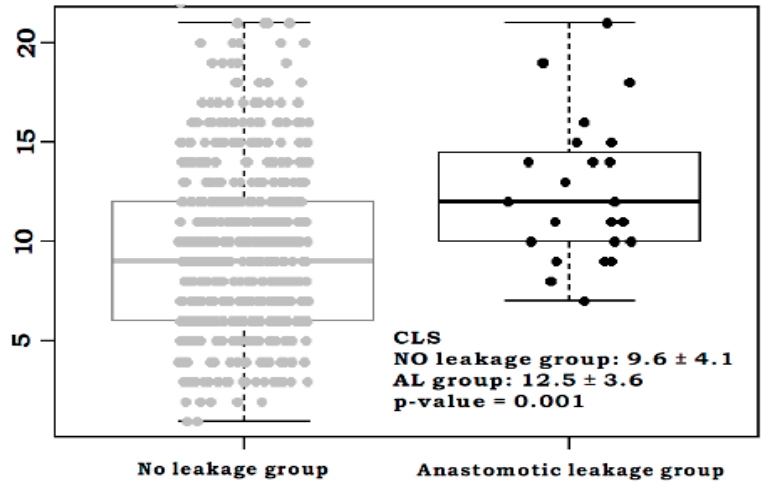
Figure 1. Comparison of colon leakage score according to the leakage status. The mean colon leakage score (CLS) was significantly higher in the anastomotic leakage group than the No leakage group (Mean ± standard deviation: 12.5 ± 3.6 in the AL group versus 9.6 ± 4.1 in the No leakage group, p = 0.001). Table 1. Comparison of patient characteristics between AL group and No leakage group.